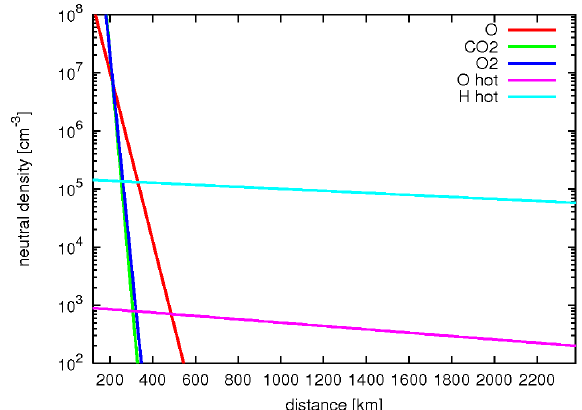
Fig. 5. Neutral density per species used in hybrid simulations. The atmospheric profiles were taken from Krasnopolsky (2002), Exo- spheric hydrogen and oxygen profiles from Chaufray et al. (2007) for solar minimum conditions. Note the two orders of magnitude denser exospheric hydrogen density than the oxygen density. Ions are produced by photoionization and charge exchange in the range 200km – 2 R M above the surface.